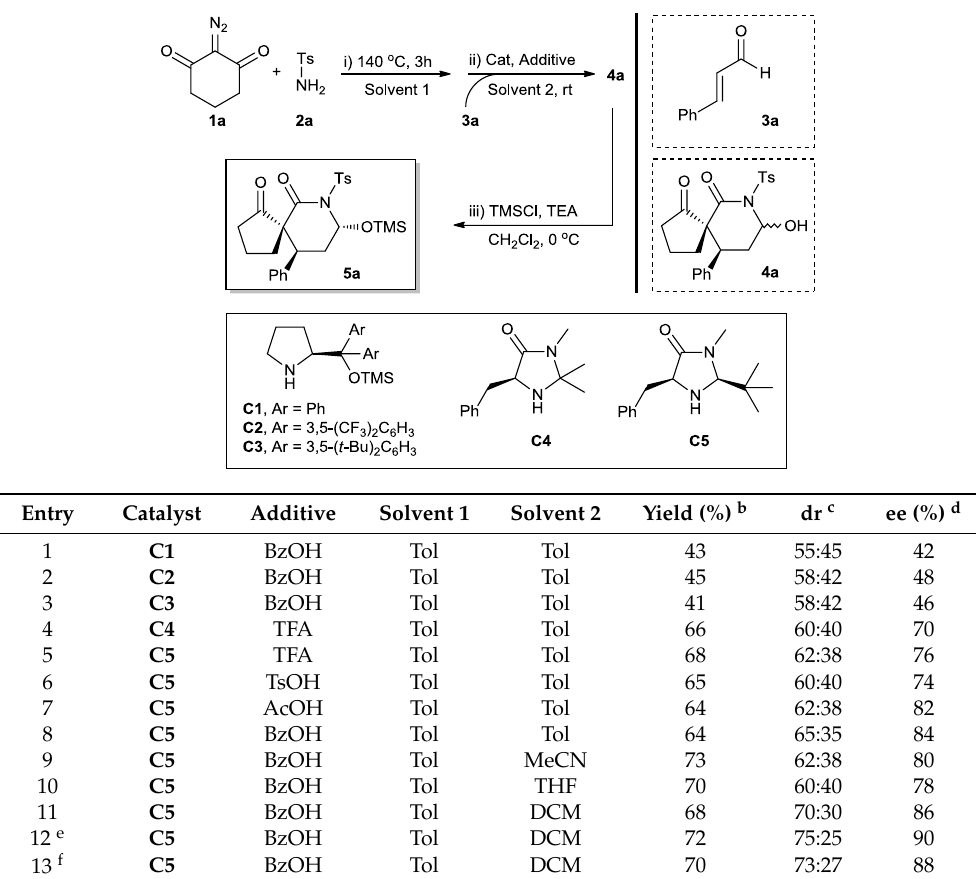
Table 1. Optimization of reaction conditions a .